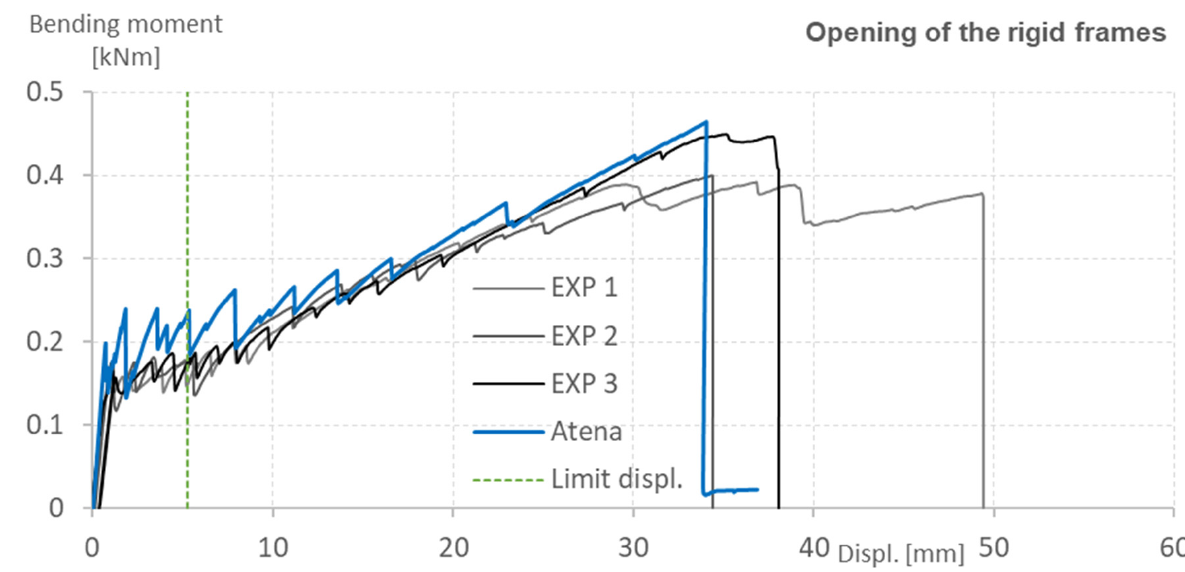
Figure 13. Opening of the rigid frames. Comparison of numerical analysis prediction and experimentally tested specimens.